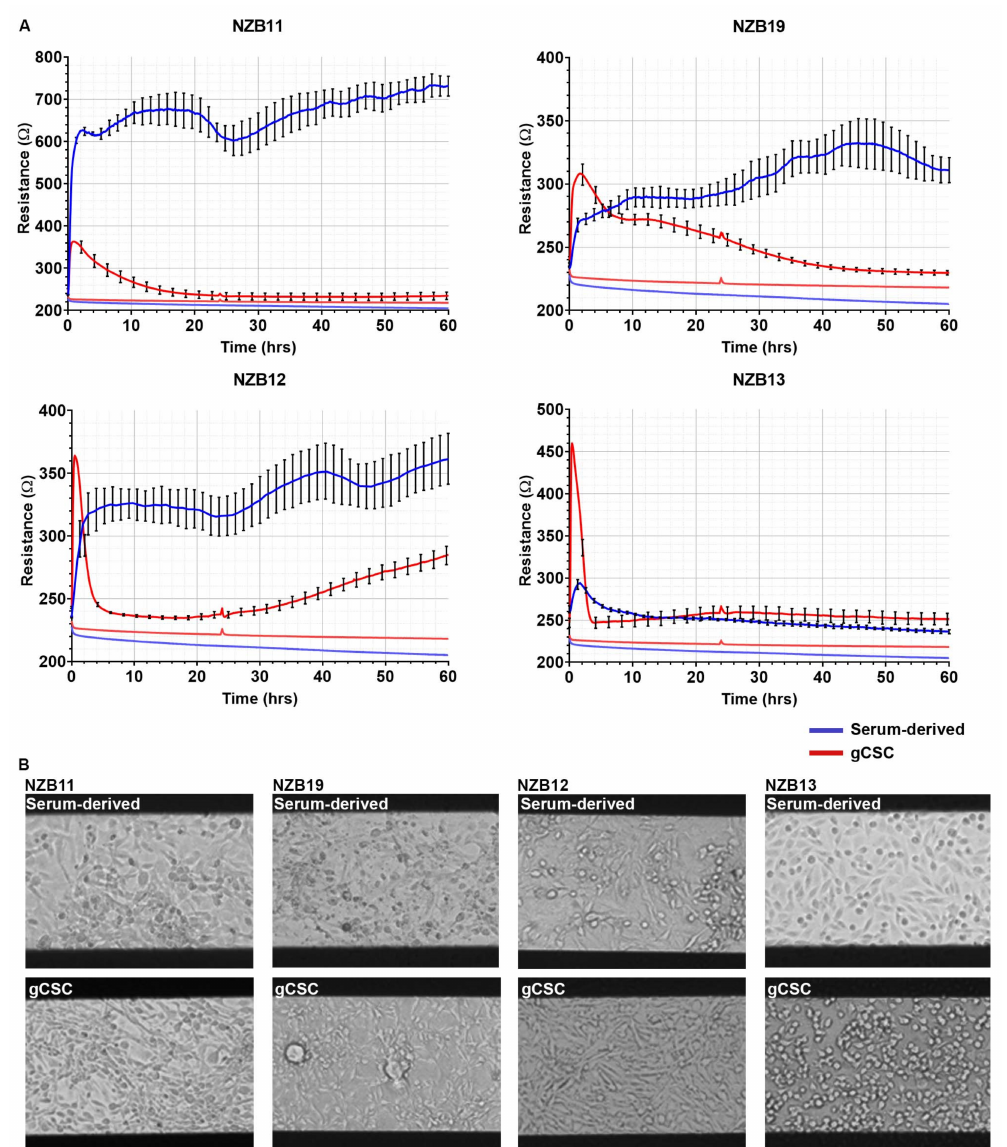
Figure 3. Serum-derived and gCSC cell resistance on 96W20IDF ECIS arrays. ( A ) Resistance measurements at 4000 Hz over 60 h of growth. Comparison of adhesion profiles of NZB11, NZB12, NZB19, and NZB13 serum-derived and gCSC cells seeded at 80,000 cells. Adhesion profiles referenced against a cell-free control (bottom flat red and blue lines) are shown. Data are representative of three independent replicates. ( B ) Phase contrast images of NZB11, NZB12, NZB19, and NZB13 serum-differentiated and gCSC cells after 60 h of growth on 96W20IDF ECIS arrays. The dark bands are the interdigitated electrodes. Images acquired at 20 × magnification. Data are representative of three independent